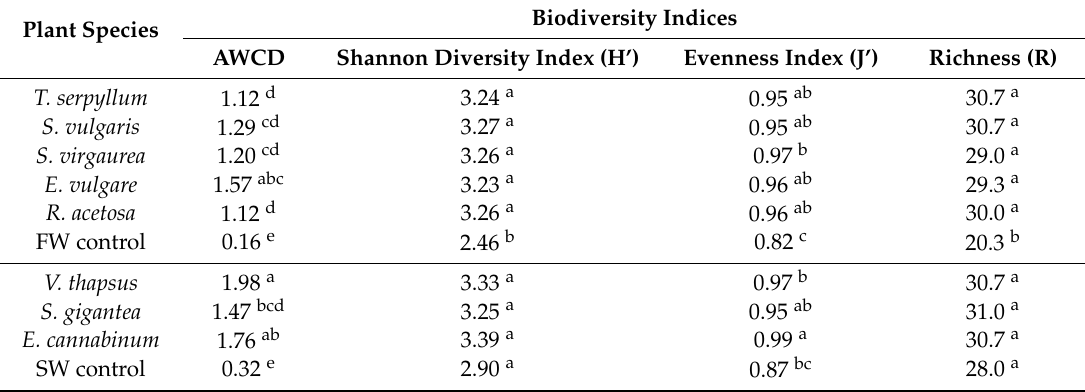
Figure 1. Changes in the average well colour development (AWCD) of carbon source utilisation in the Biolog EcoPlate from 1 h to 196 h (values are means, n = 3). Table 7. Biodiversity indices of FW and SW soils based on substrate utilisation pattern in the Biolog EcoPlate at time 144 h.